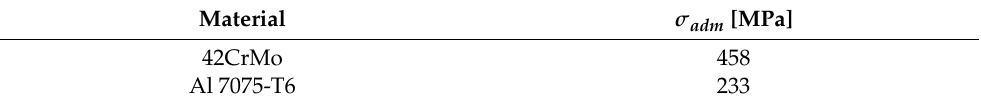
Table 8. Allowable stresses for steel and